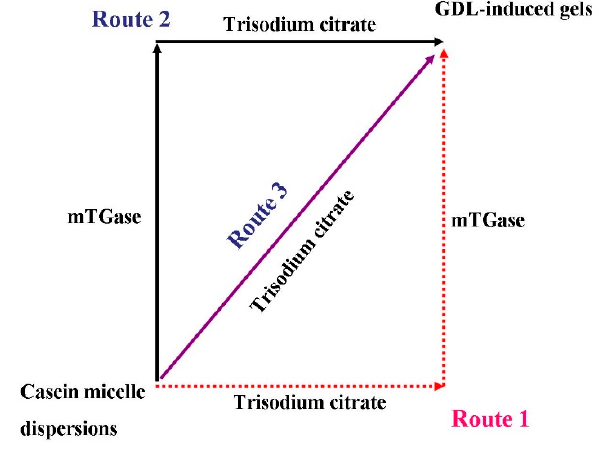
Figure 4. The schematic representation of the gel preparation route.